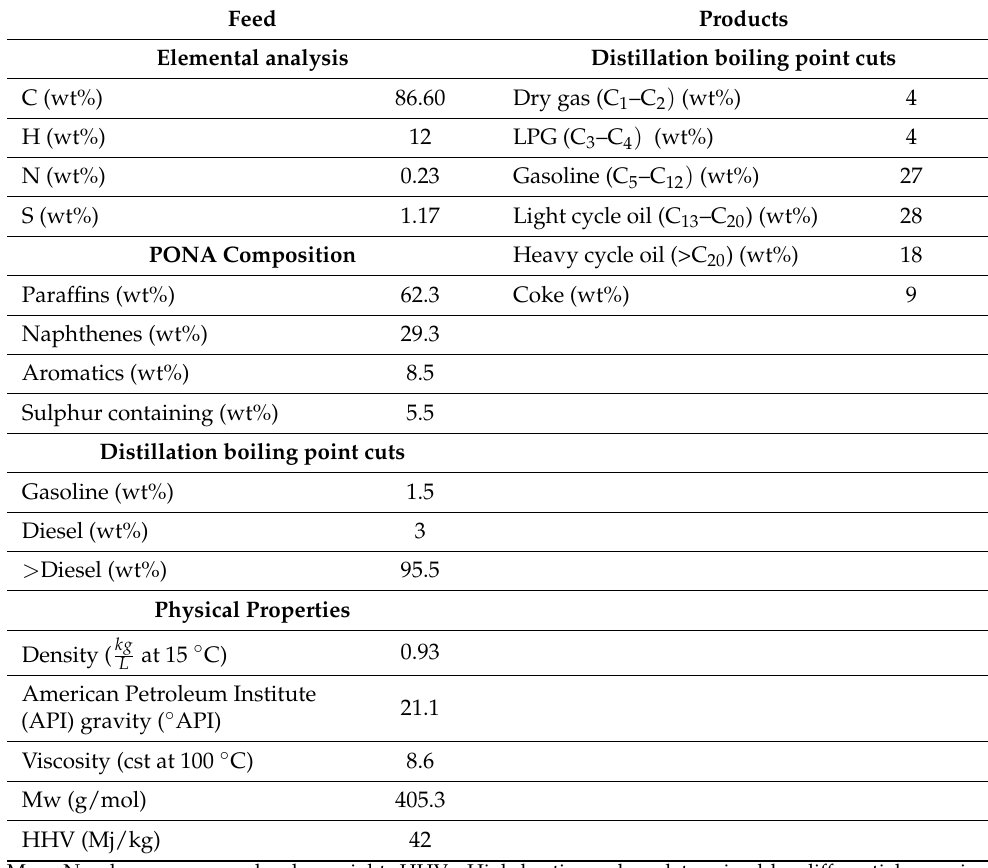
Table 3. Feed and product characterisation from an FCC riser pilot plant using vacuum gas oil feed and commercial equilibrium catalyst containing 15.5% zeolite